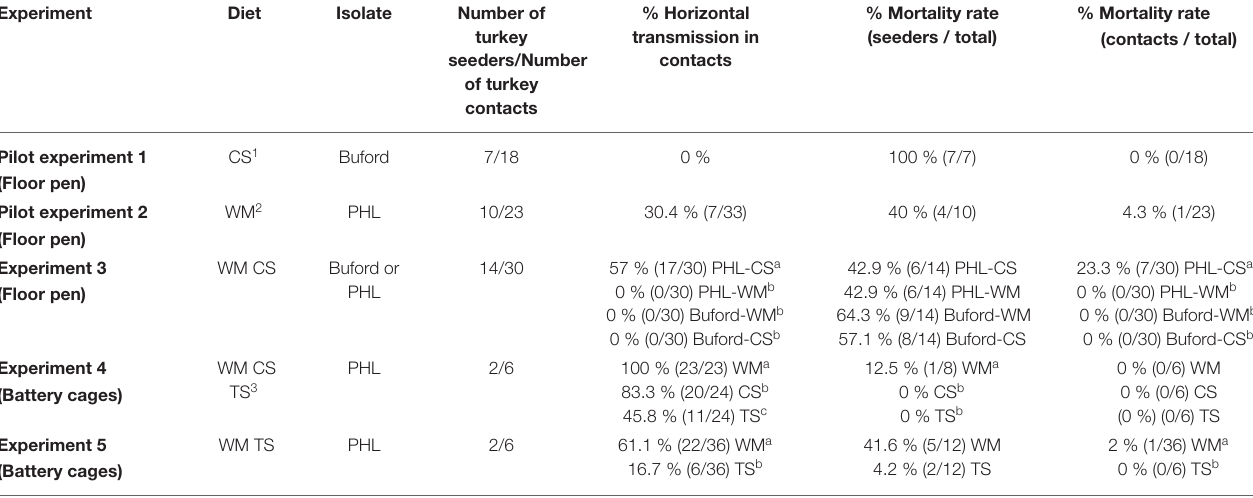
TABLE 2 | Summary of the results of the horizontal transmission, evaluated as the % frequency of lesions in ceca and/or liver in contact turkeys for all five experiments evaluating different feed compositions and isolates of Histomonas meleagridis . Experiment